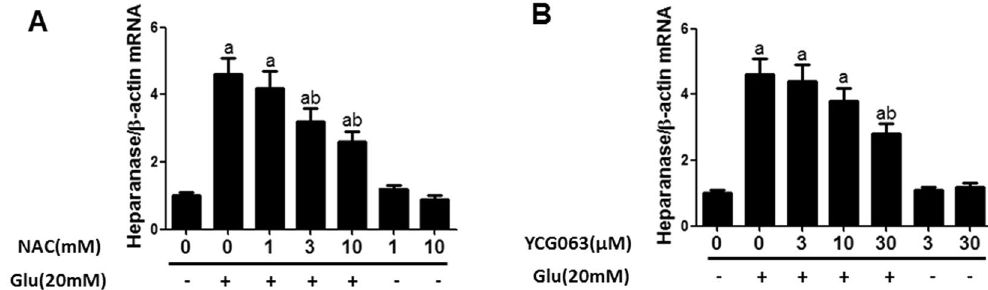
Figure 6. ROS inhibition blocked heparanase expression induced by high glucose stimulus in cultured podocytes. ( A ) The dose-response effect of ROS inhibitor NAC on podocyte heparanase mRNA expression. Control: PBS incubation for 18 h; Glucose: 20 mmol/L glucose incubation for 18 h; NAC + Glucose: 1, 3, 10 mM NAC pre-incubation for 1 h and followed by 20 mmol/L glucose exposure; NAC: 1, 10 mM NAC incubation alone. ( B ) The effect of ROS inhibitor YCG063 on podocyte heparanase expression. Control: PBS incubation for 18 h; Glucose: 20 mmol/L glucose incubation for 18 h; YCG063 + Glucose: 3, 10, 30 µ M YCG063 pre- incubation for 1 h and followed by 20 mmol/L glucose exposure. YCG063: 3, 30 µ M YCG063 incubation alone. Data are presented as mean ± SD. P < 0.05 is statistically significant. a Indicates significant vs. Control, b indicates significant vs.